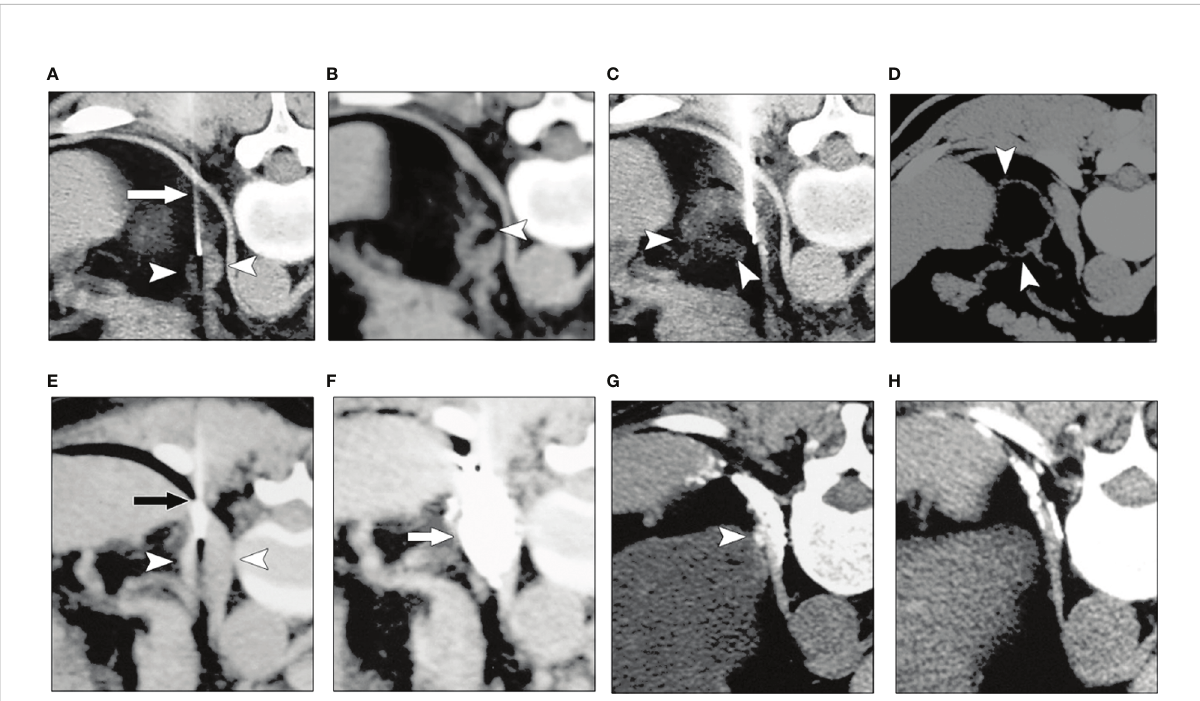
FIGURE 1 Chemical ablation of left adrenal adenoma with anhydrous alcohol (A – D) . (A) Transverse CT image obtained with the patient in a prone position showed a fi ne needle (arrow) in the left adrenal mass (arrowheads). (B) , CT image obtained after the fi rst injection of alcohol revealed a focal collection of alcohol in the adrenal tumor (arrowhead). (C) , CT image obtained after the third ethanol injection shows the distribution of alcohol in tumor (arrowheads) was more diffuse than in (B, D) Follow-up CT image obtained one year after (A – C) revealed that most of the lesion (arrowheads) was replaced by fatty tissue. Chemical ablation for left adrenal metastases from the renal carcinoma after total left nephrectomy (E – H) . (E) A transverse CT scan with the patient in a prone position showed a needle (arrow) in the left adrenal mass (arrowheads). (F) The image obtained after the second injection of acetic acid and iodized oil showed good compound permeation (arrow). (G) Six months later, the follow-up CT image showed a remaining dotlike lesion (arrowhead), and iodized oil was within the diaphragm. (H) One year after A and B, a follow-up CT image showed the lesion had fully resolved (4). (Zhang JS et al, AJR ,